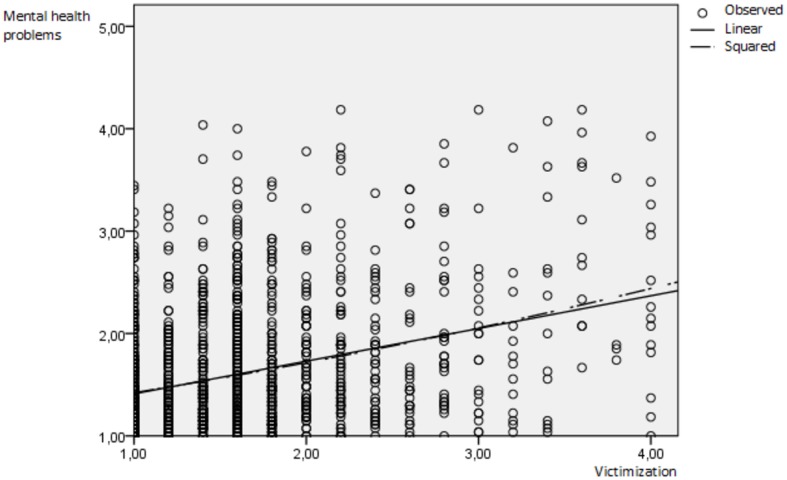
Linear and convex prediction of mental health problems by victimization. Observed = observed value, linear = linear line of parameter estimation, squared = squared (convex) line of parameter estimation.